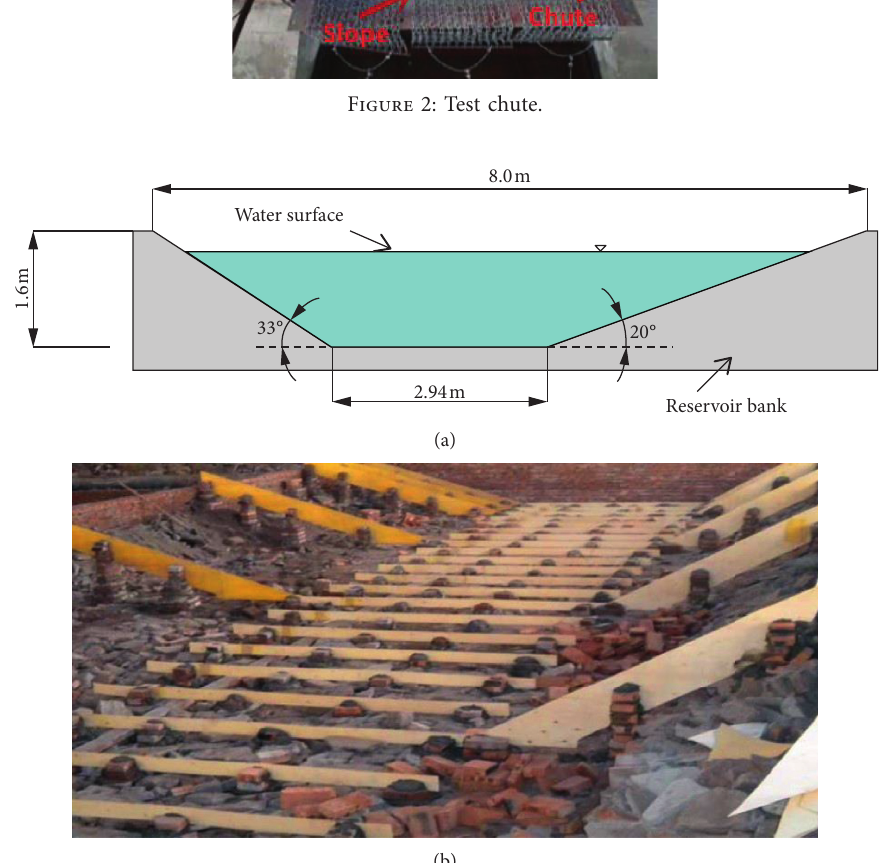
Figure 3: Cross section. (a) Global diagram. (b) Local